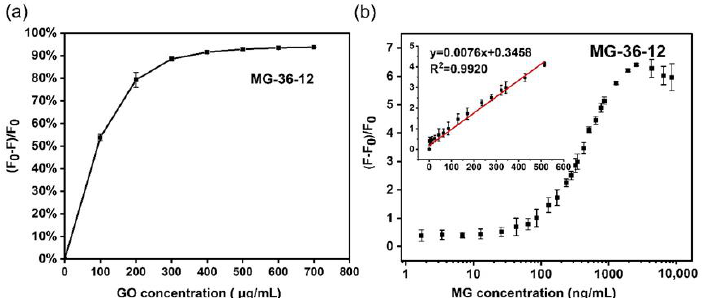
Figure 4. GO concentration optimization and sensitivity test of aptamer MG-36-12 in GO-based fluorescent aptasensor. ( a ) GO concentration for the fluorescence quenching of FAM-labeled aptamer, MG-36-12. ( b ) The relative fluorescence intensity of FAM aptamer after incubation with a series of concentrations of MG (0–8571.43 ng/mL). The inset shows a linear relationship (R 2 = 0.9920) with the concentration of MG in the range of 1.71 – 514.29 ng/mL. Error bars were obtained from three parallel experiments. 2. Figure 5b was corrected, and the slope of fitted curve in Figure 5b was revised to 0.0045.